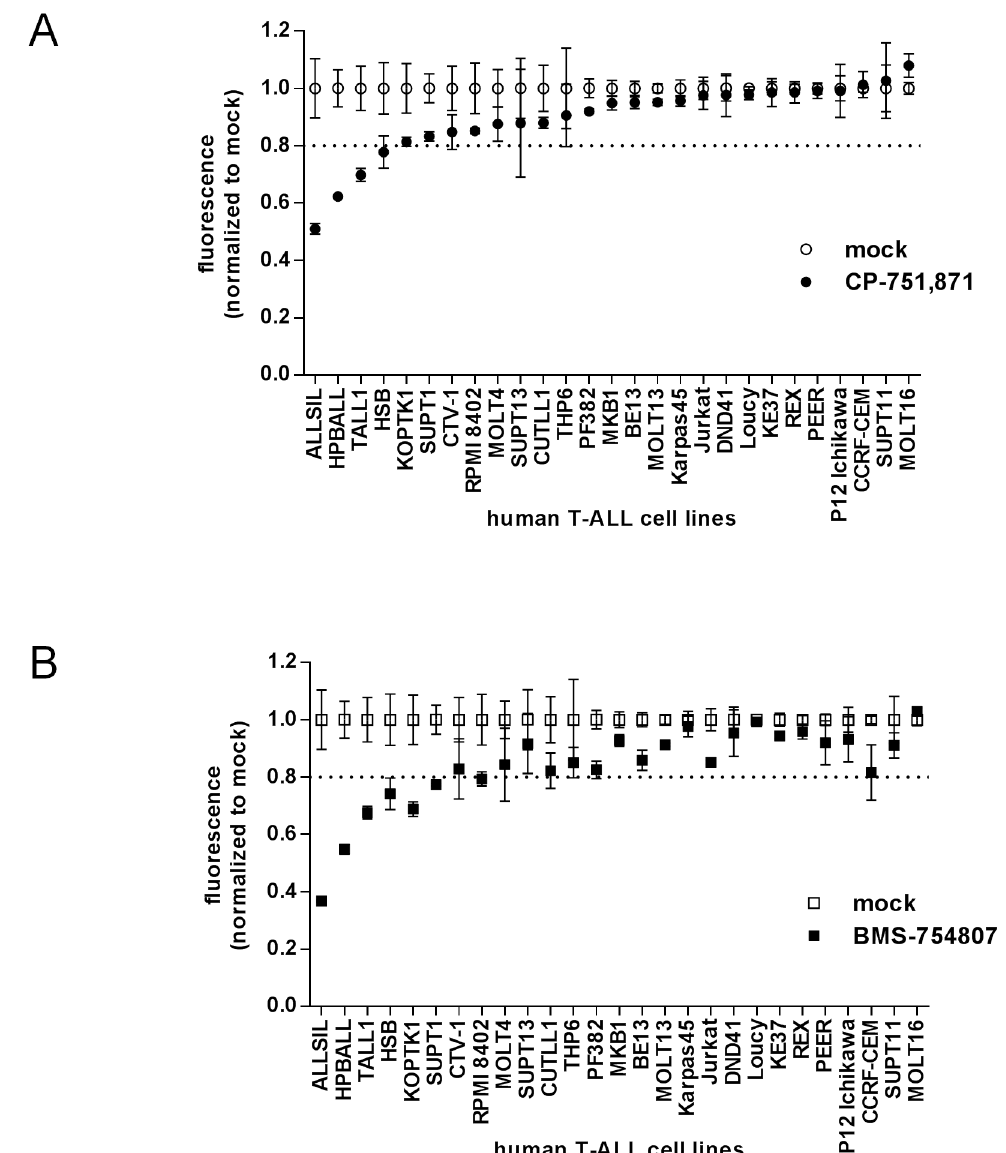
for 3 days with either ( A ) IGF1R blocking antibody (CP-751,871; 1 μ g/ml) versus PBS vehicle control (mock) or ( B ) dual IGF1R/InsR tyrosine kinase inhibitor (BMS-754807; 0.5 μ M) versus DMSO vehicle control (mock). Mean resorufin (reduced resazurin) fluorescence values +/- SD after normalization to mock-treated controls are plotted for assays performed in triplicate. Cell lines are rank ordered left-to-right by decreasing effect of the CP-751,871 blocking antibody. The horizontal dotted line indicates the 20% growth inhibition